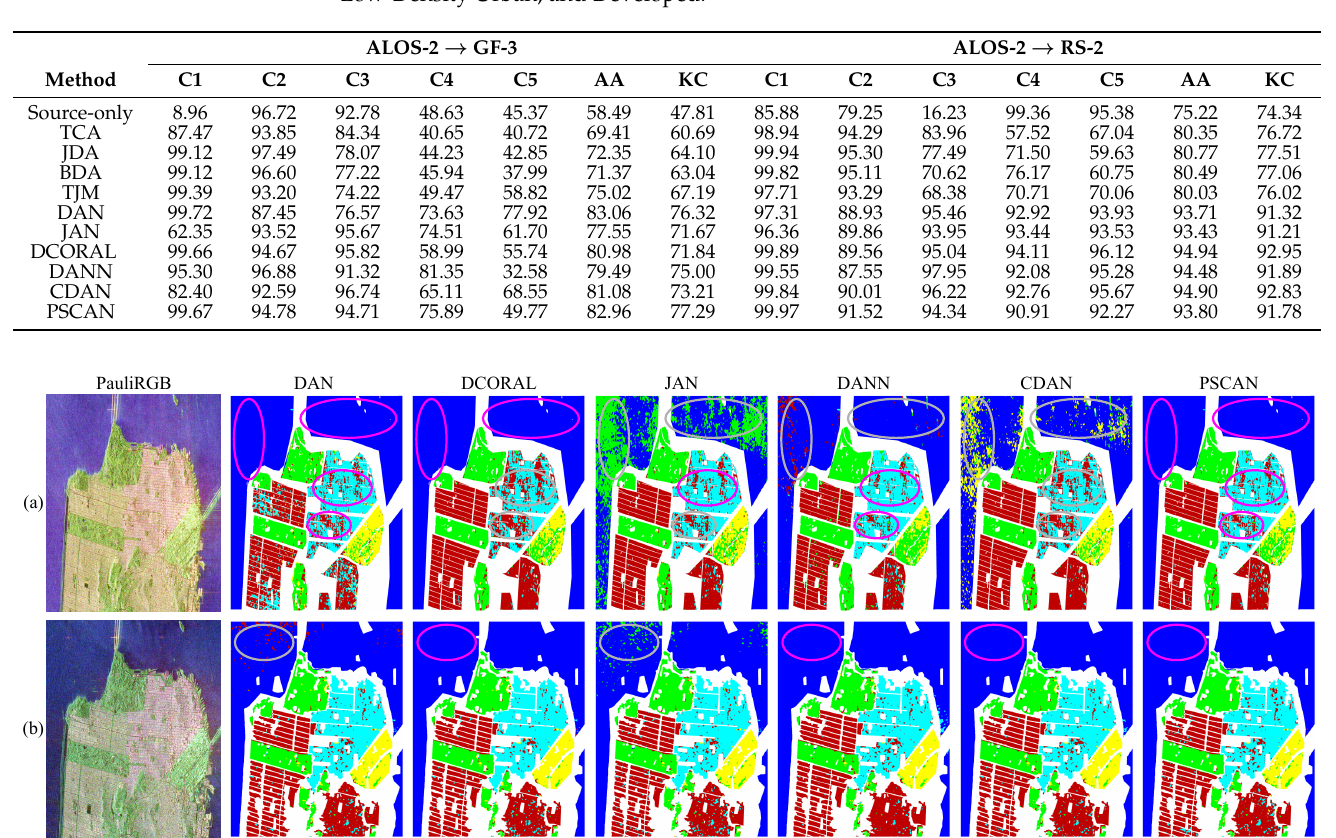
Table 2. Comparison of experimental results (%) on the San Francisco area when the source domain is set to ALOS-2. The C1 to C5 refer to different categories: Water, Vegetation, High-Density Urban, Low-Density Urban, and Developed.